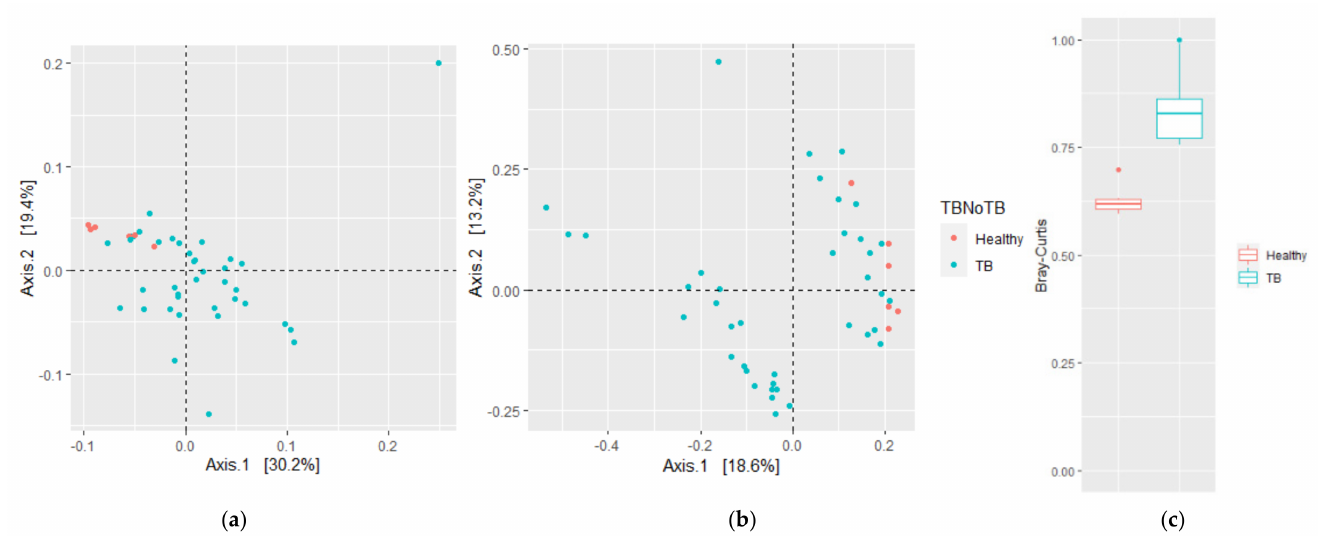
Figure 2. Community structure of sputum microbiota of HVs and TB patients. Principal coordinate analysis (PCoA) plots based on ( a ) weighted and ( b ) unweighted UniFrac distances show significant distinct bacterial community clusters between TB patient and HV lung microbiota. ( c ) Bray–Curtis dissimilarity index. Plots represent HV samples (red symbols) and TB patient samples (green). Statistical significance between groups in ( c ) is indicated by ( p < 0.05; ADONIS